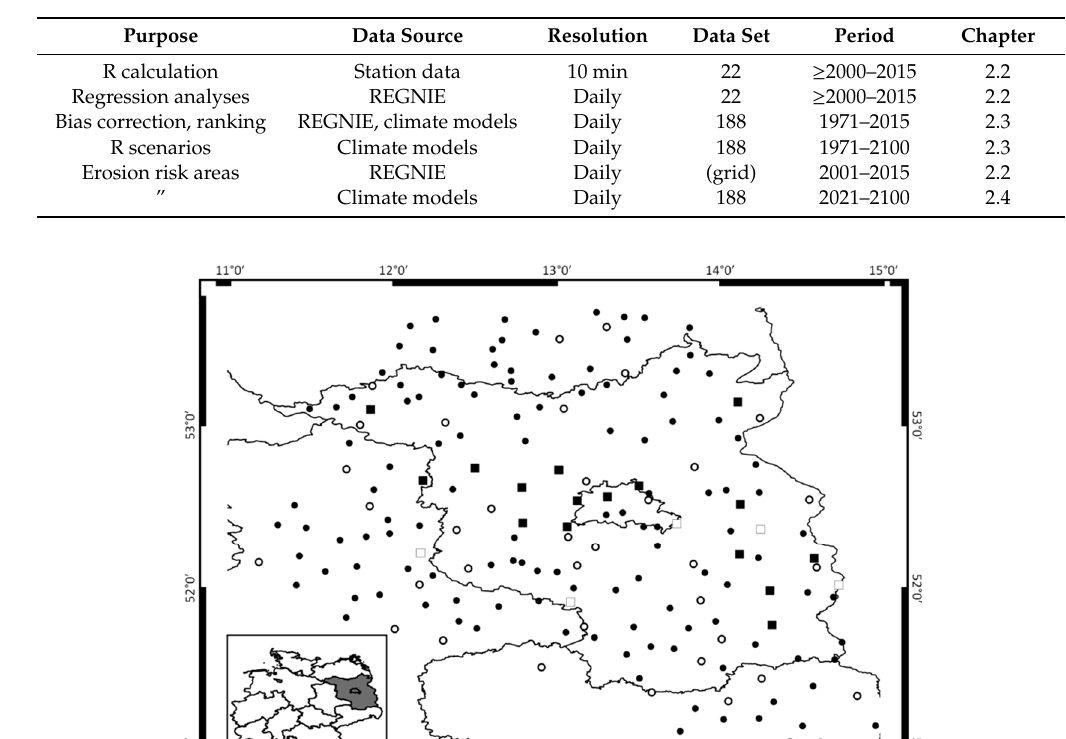
(cf. Figure 2 in the Results section). For each climate station, P sum , P max10 , and P 11.8 were calculated as multi-annual means for the years in Table 1.